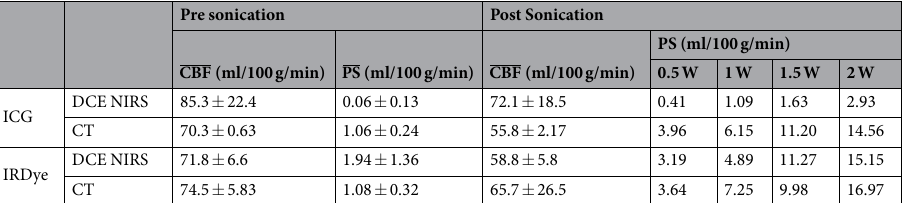
Table 1. Mean pre and post sonication CBF and PS values obtained by DCE NIRS and CT as well as individual PS values measured at each of the four sonication powers.